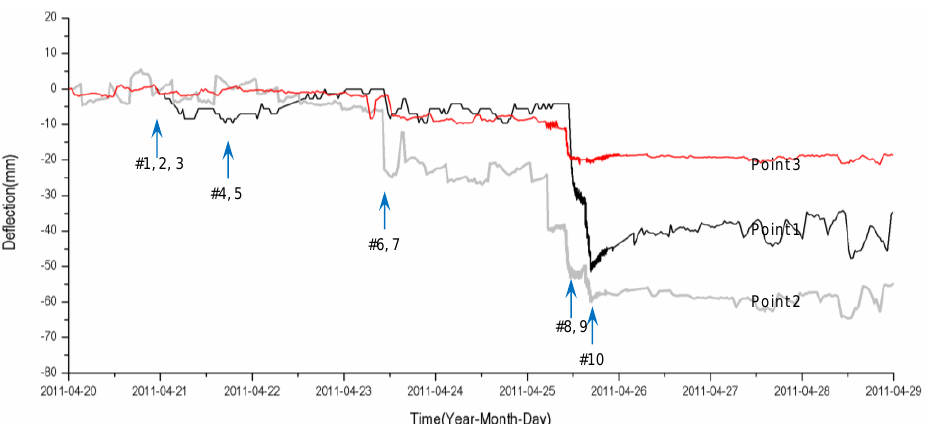
Figure 7. Vertical displacement